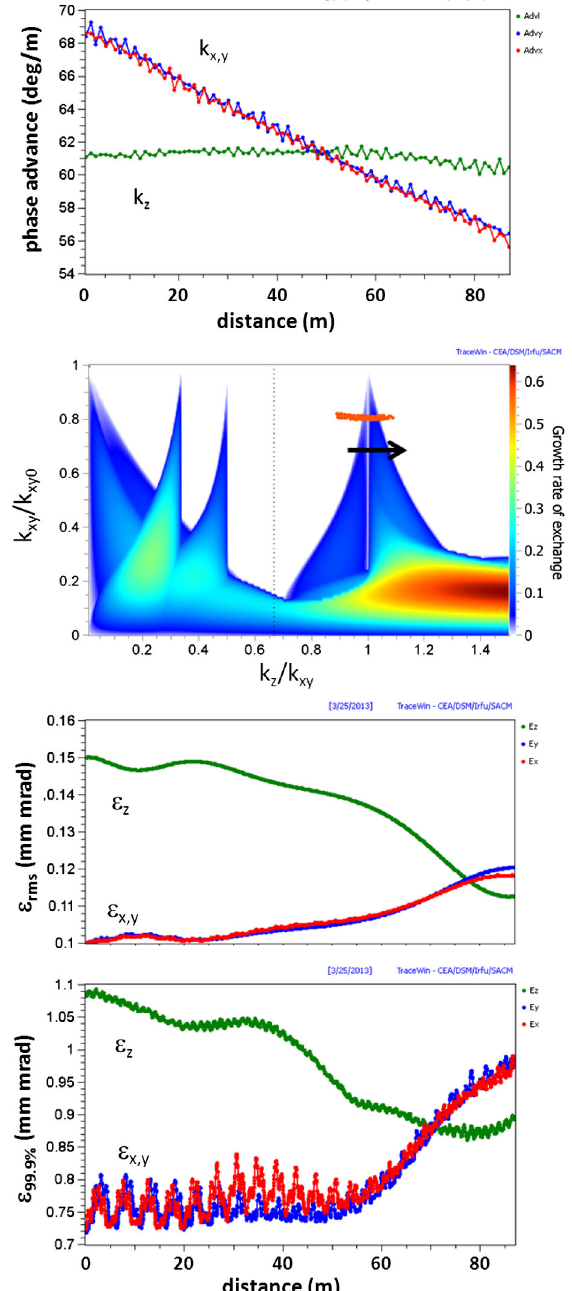
FIG. 3. Crossing of main resonance from left to right in the absence of extra halo: TRACEWIN results for k z and k xy (top); tune footprint on stability chart for (cid:2) z =(cid:2) x ¼ 1 : 5 (below top, with arrow marking direction); rms (above bottom); and 99.9% (bot- tom)